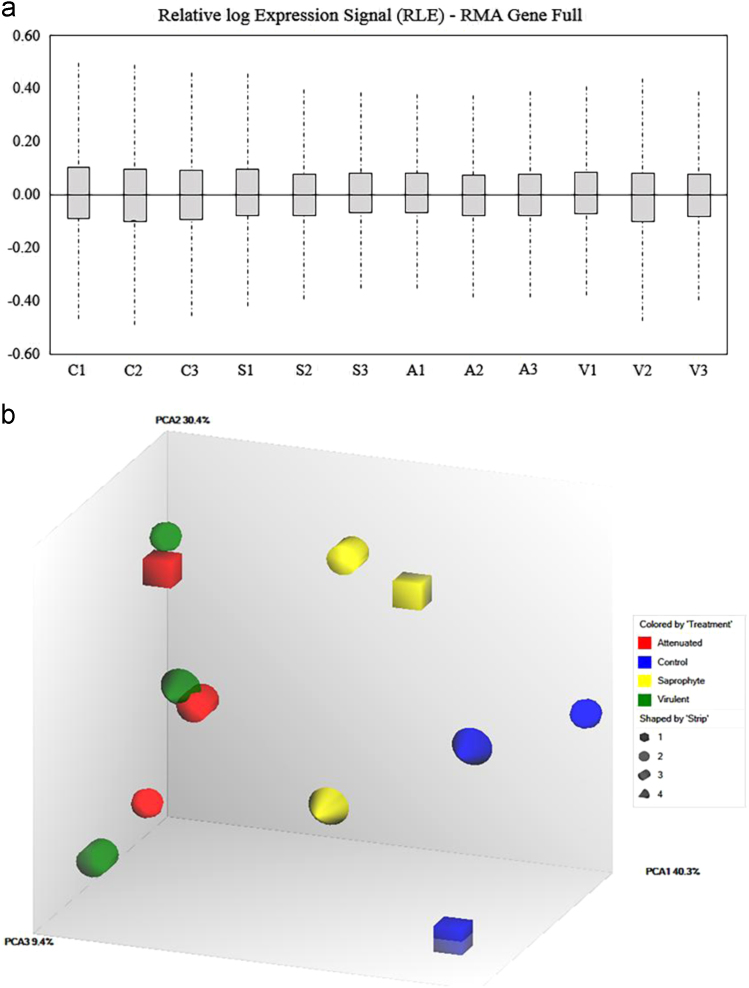
Signal distribution after normalization. a) Values of relative log expression signal after RMA-DABG normalization between all samples. (b) Principal component Analysis of probe cell intensity for all samples.